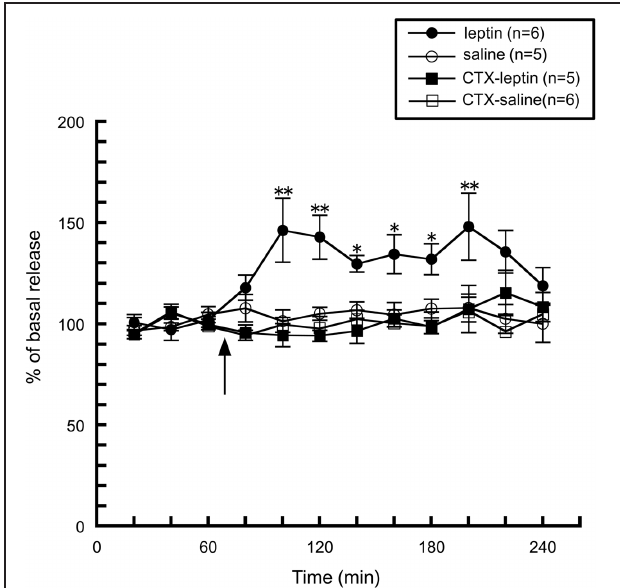
FIGURE 4 | The effect of leptin (1.3mg/kg, i.p.) on the release of histamine from the anterior hypothalamus in intact ( n = 6) and chorda tympani-transected (CTX) rats ( n = 5) (Morimoto-Ishizuka et al., 2001). The arrow indicates the time point of injection. The mean values of three baseline samples preceding the injection were taken at 100%. Values are presented as percentages of the mean basal release ± SEM ∗∗ p < 0 . 01, ∗ p < 0 . 05 compared with the basal release of each group,